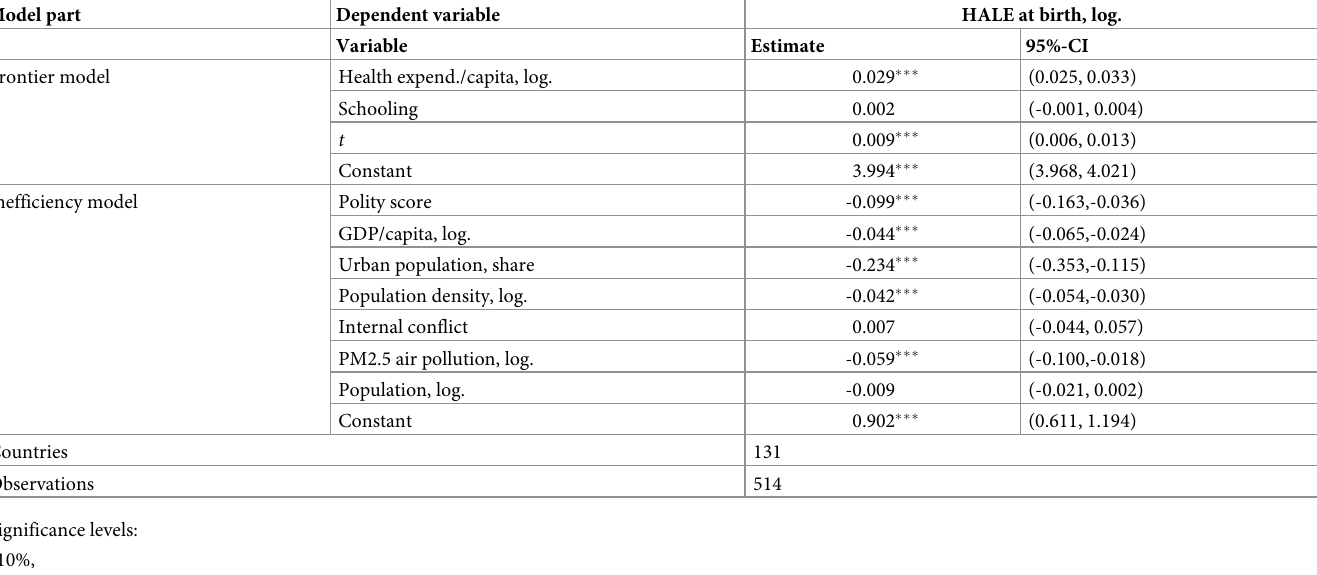
Table 4. SFA results for extended frontier